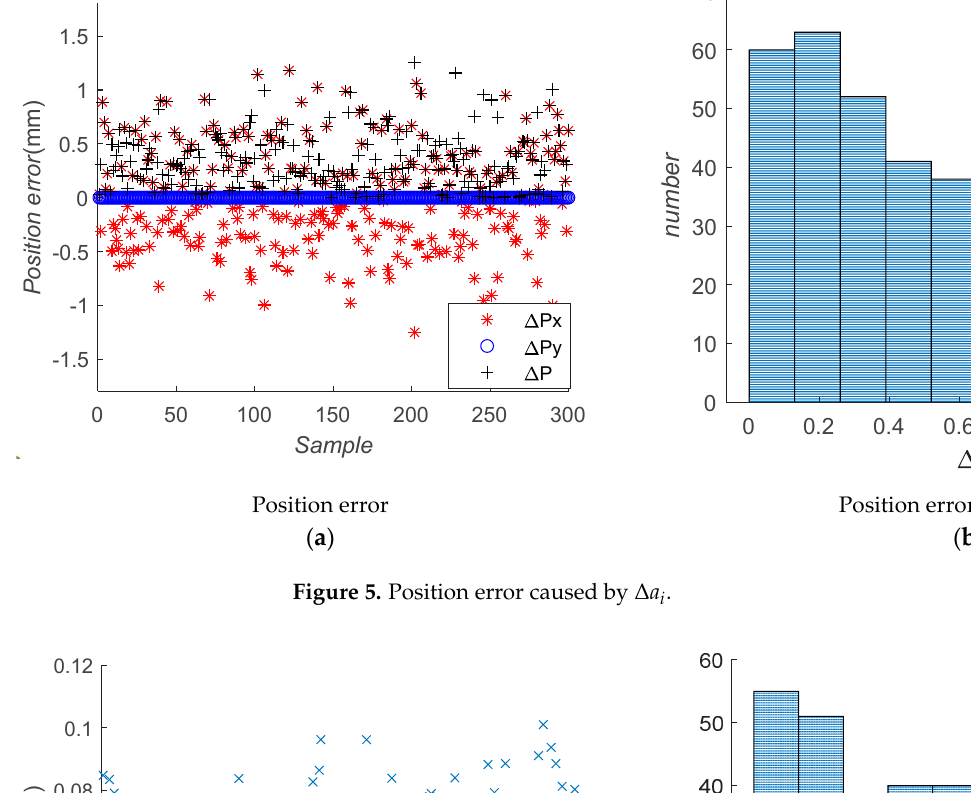
Figure 5. Position error caused by Δ a i.